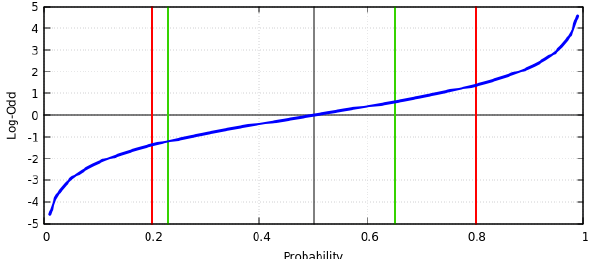
Figure 2. Symmetric (red) and asymmetric (green) clamping thresholds.